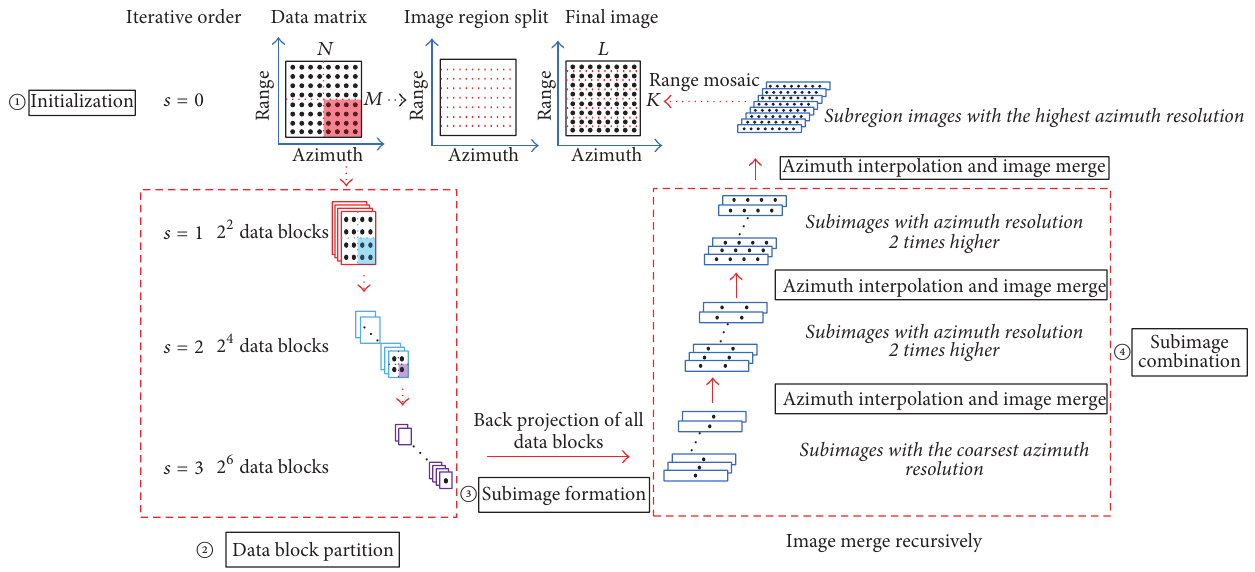
Figure 9: Schematic diagram of DBP-FFBPA for frequency stepped SAR